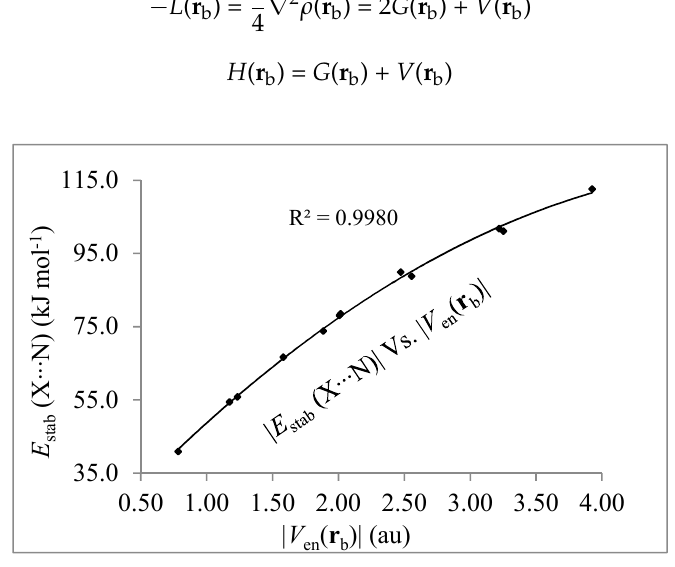
Figure 2. Correlation between E stab (X ∙∙∙ N) and | V en ( r b )|.